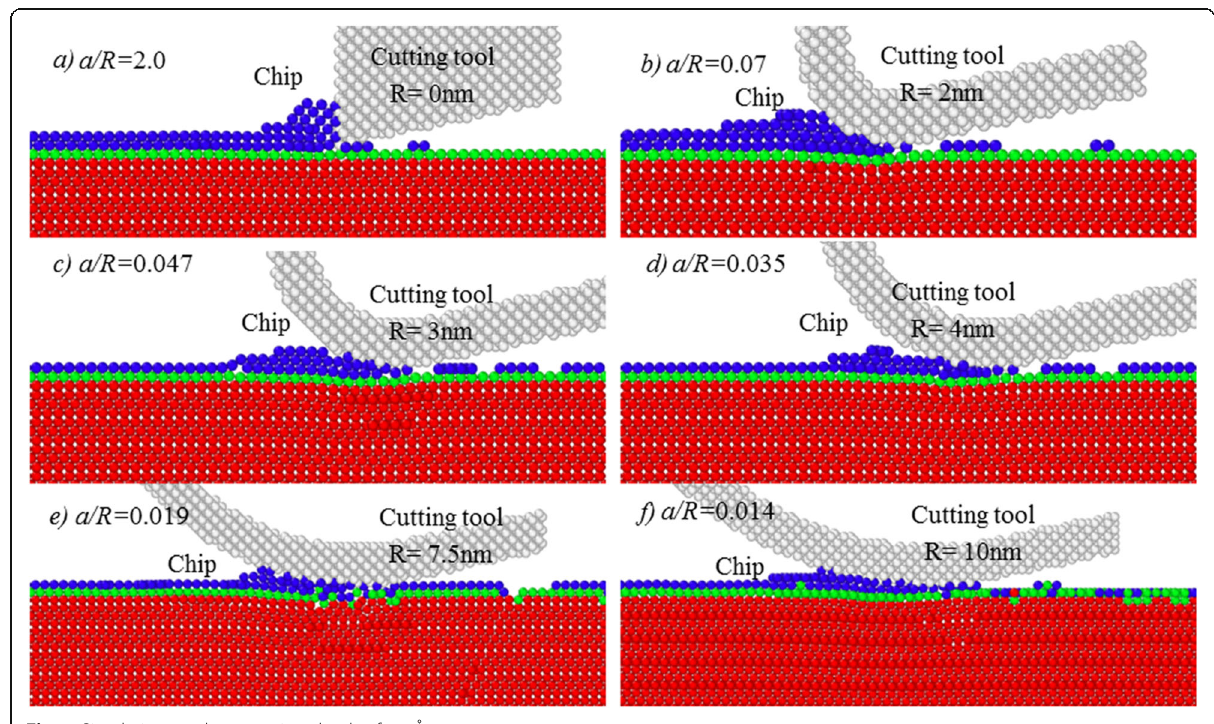
Fig. 4 Simulation results at cutting depth of 1.4